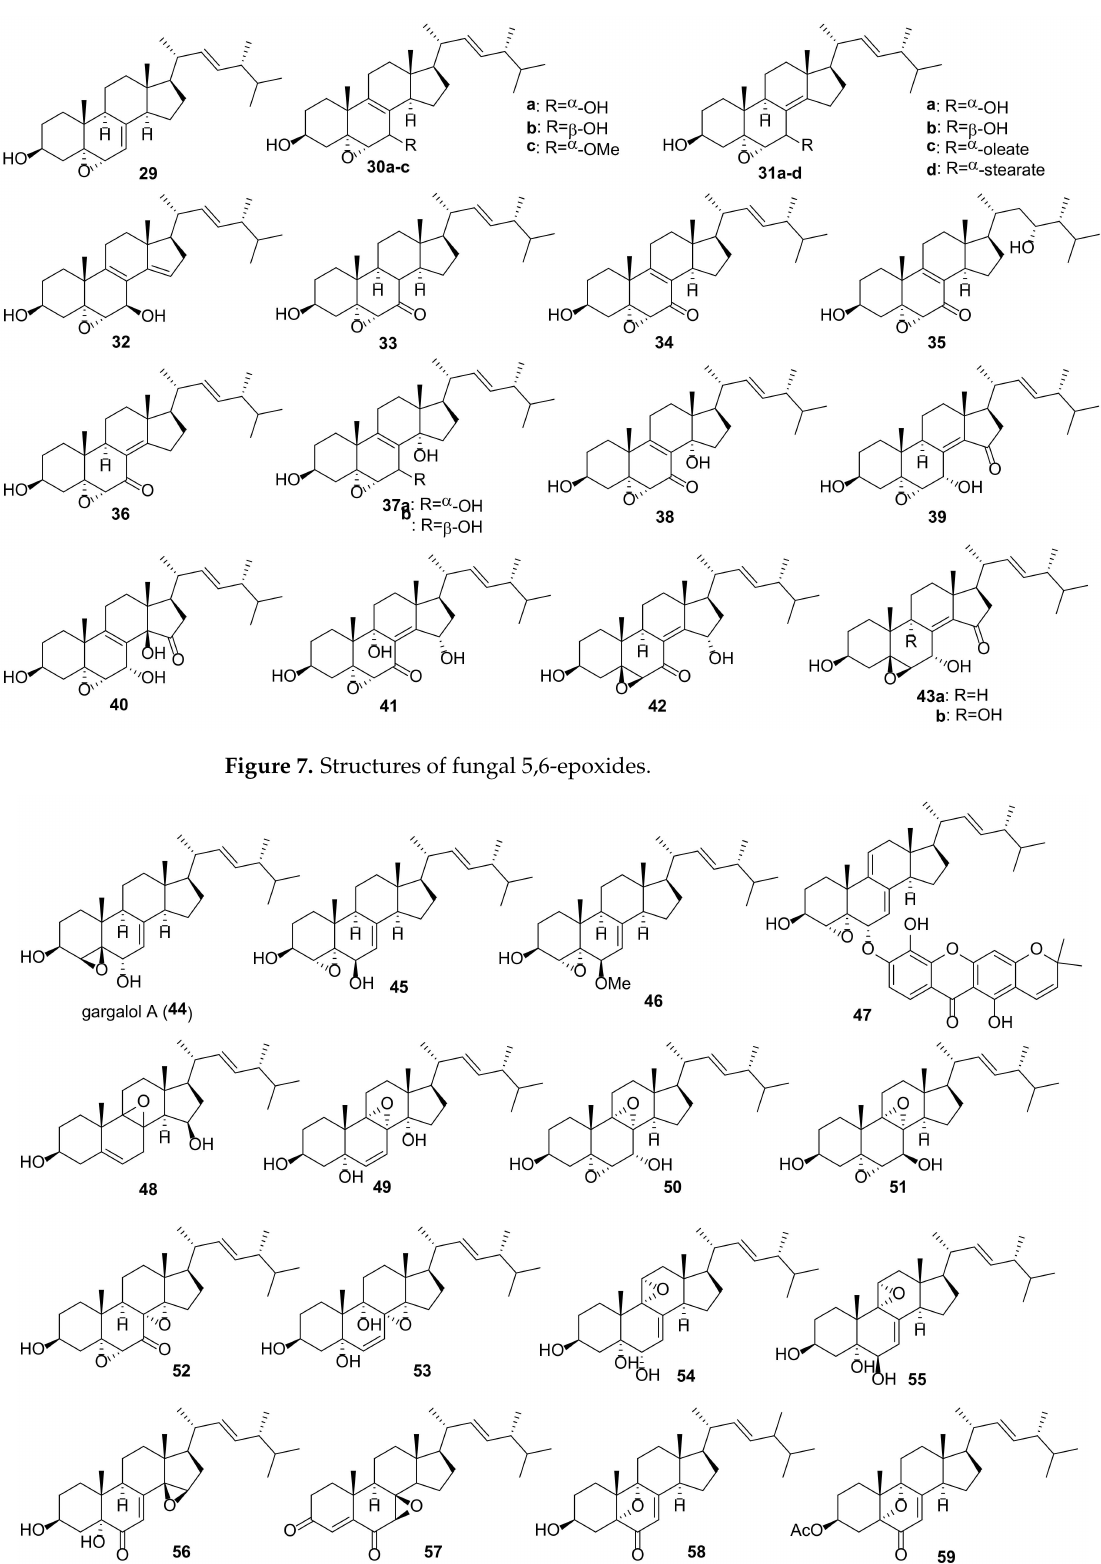
Figure 8. Structures of other fungal